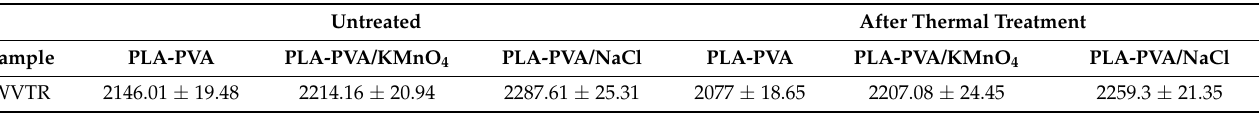
Table 4. Water vapor transmission rate of the porous bioscaffolds.